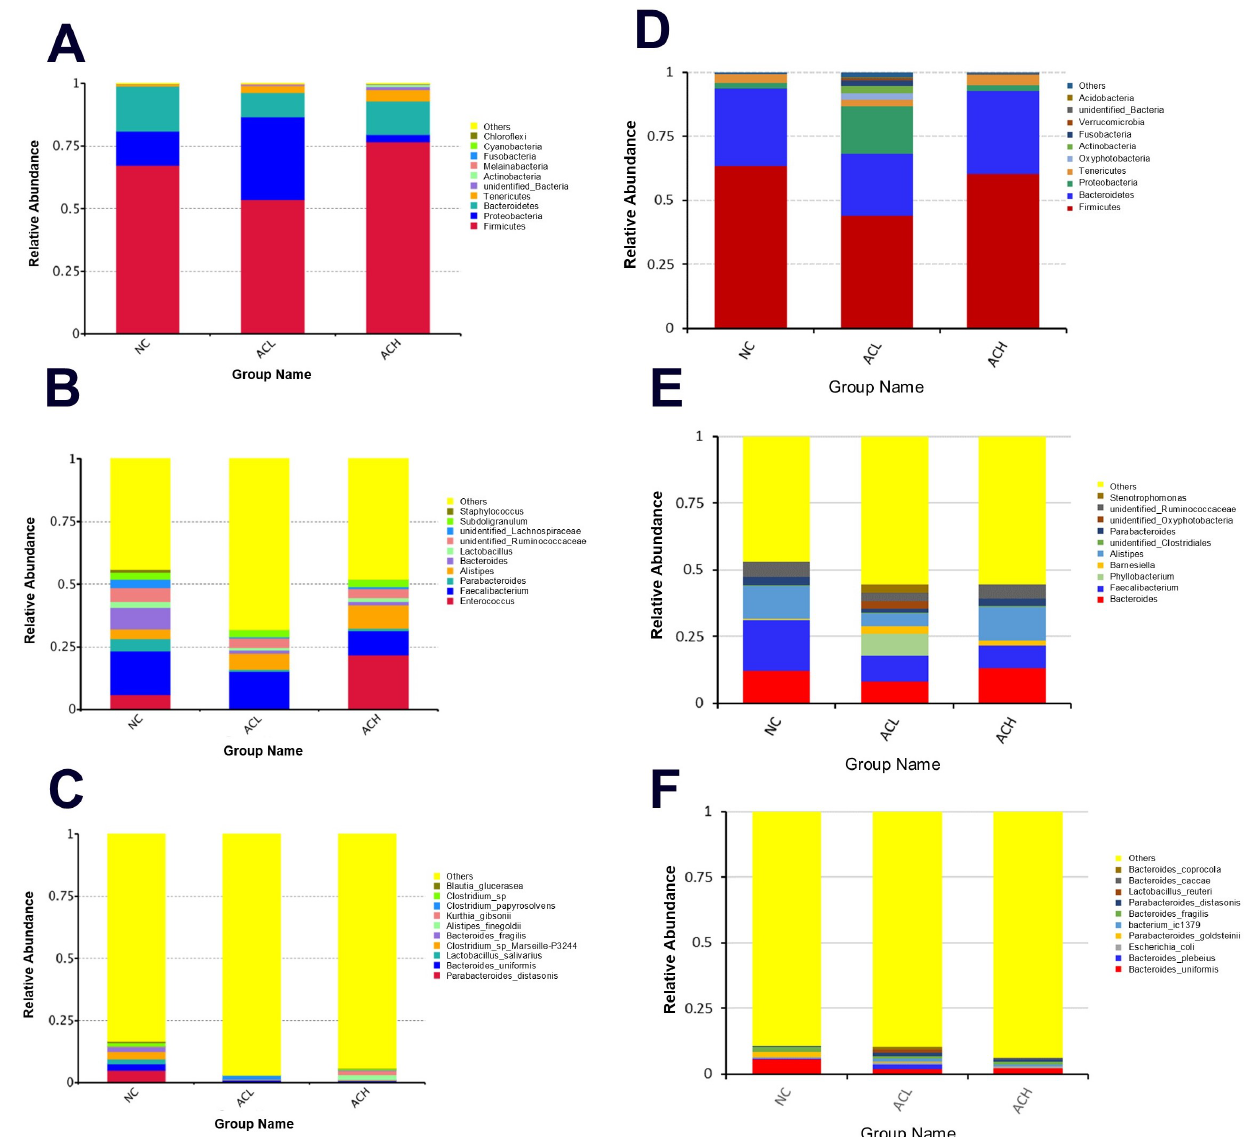
Figure 3. Taxonomic differences in the microbial community of the caeca in broilers ( n = 6) on 21 d with relative abundance levels of the bacterial ( A ) phyla, ( B ) genu, and their ( C ) species, and on 42 d with relative abundance levels of the bacterial ( D ) phyla, ( E ) genu, and their ( F )